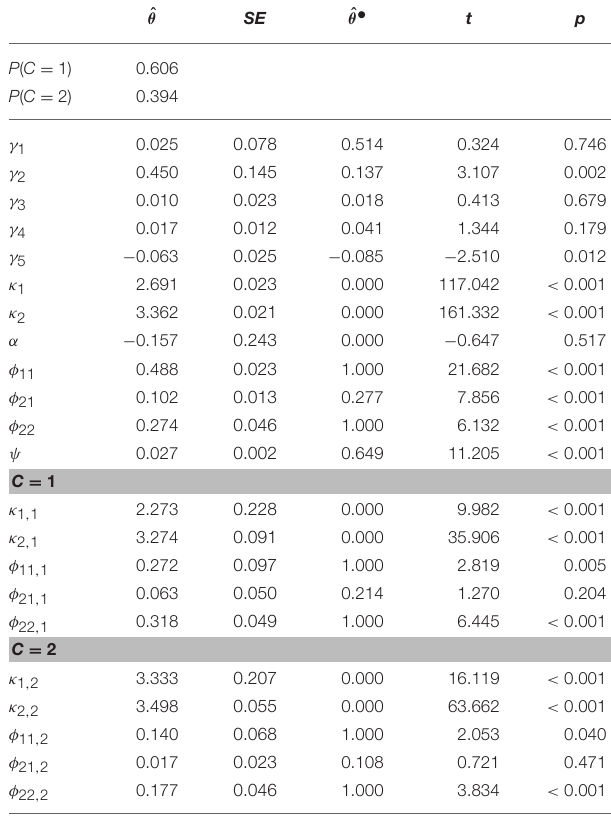
TABLE 2 | Unstandardized and standardized parameter estimates, standard errors, t - and p -values for the direct application of a nonlinear model with two latent classes.